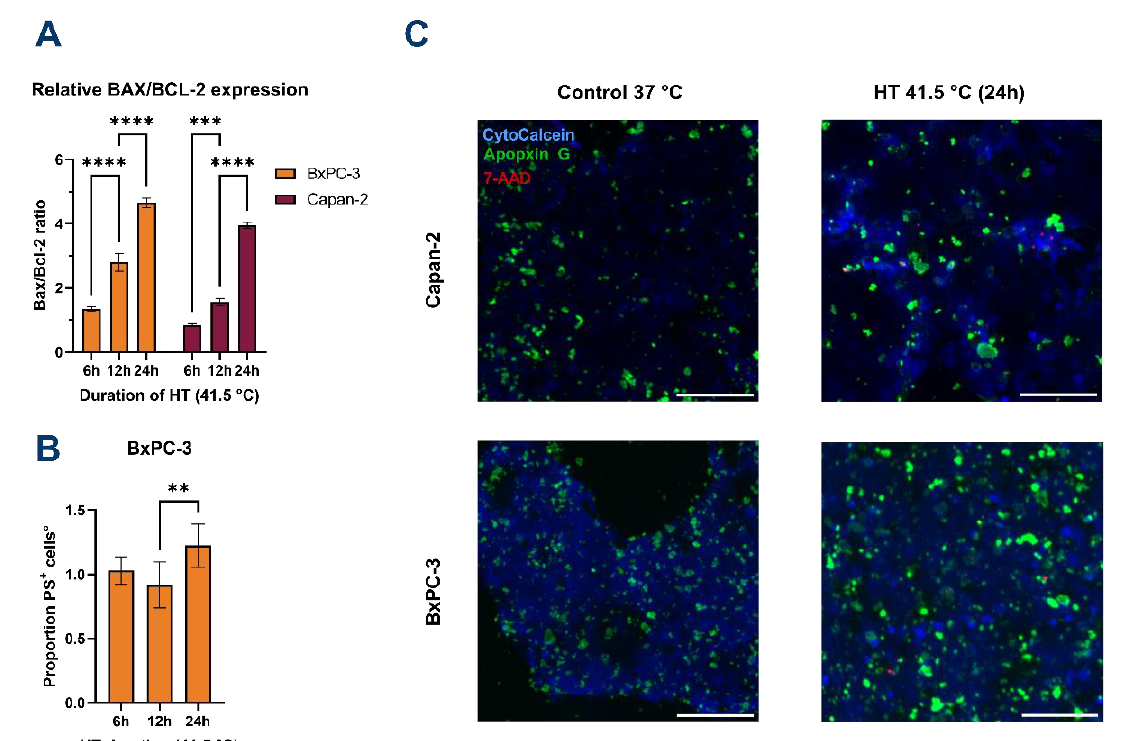
Figure 3. Hyperthermia induces apoptosis in PDAC cells. ( A ) BAX/BCL-2 expression ratio signifi- cantly increases over HT duration for both cell lines. Values were normalized for GAPDH expression and calculated relative to controls at 37 ◦ C. ( B ) Expression of phosphatidylserine (PS) on the outer membrane is significantly increased after 24 h of HT only for BxPC-3. Data are normalized to controls at 37 ◦ C. Data for Capan-2 are shown in Supplementary Figure S1. No significant differences in PS positivity were observed for Capan-2. ( C ) Representative fluorescence microscopy imaging of BxPC-3 and Capan-2 cells at 37 ◦ C (control) and after 24 h at 41.5 ◦ C. Viable cells are stained blue, apoptotic cells are stained green (PS), and necrotic nuclei are stained red. Images were acquired at 4 × magnification. Scale bars represent 200 µ m. All error bars represent 95% CI. Statistical significance ** p < 0.001; *** p < 0.0001; **** p <